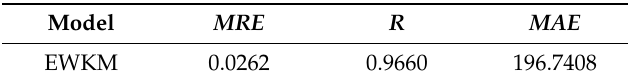
Table 3. Indicators of the EWKM.